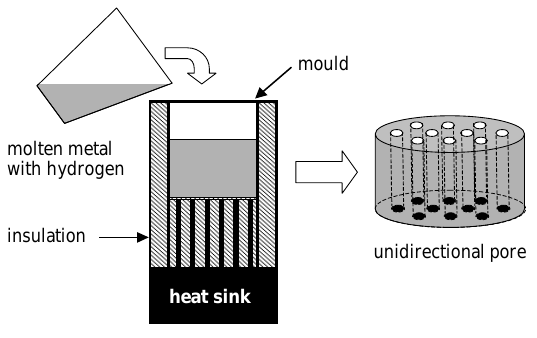
Apparatus for solid-gas eutectic solidification and porous material (modified from Nakajima